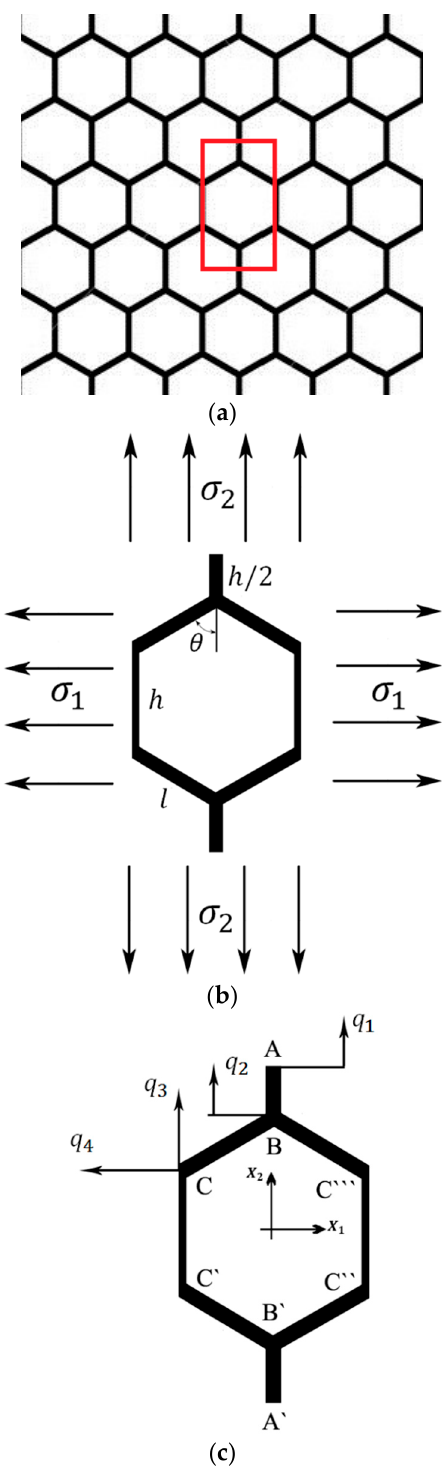
Figure 2. ( a ) A honeycomb structure; ( b ) a single unit cell of the honeycomb considered for analytical solution; and ( c ) degrees of freedom acting on the considered unit cell.